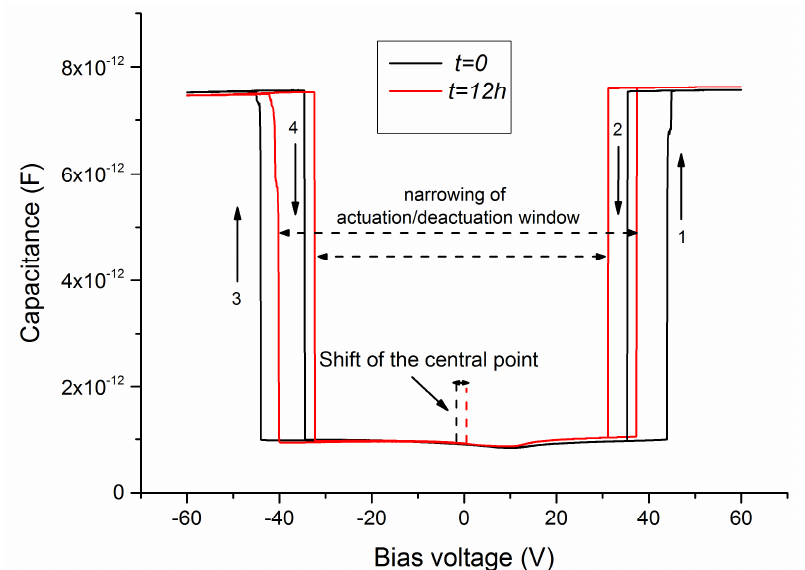
Figure 3. C–V curve of a dielectric-less capacitive switch before and after applying a positive bias at 60 V for 12 hours. Charging phenomena are strongly reduced (small shift of the central point) and narrowing effects become visible.